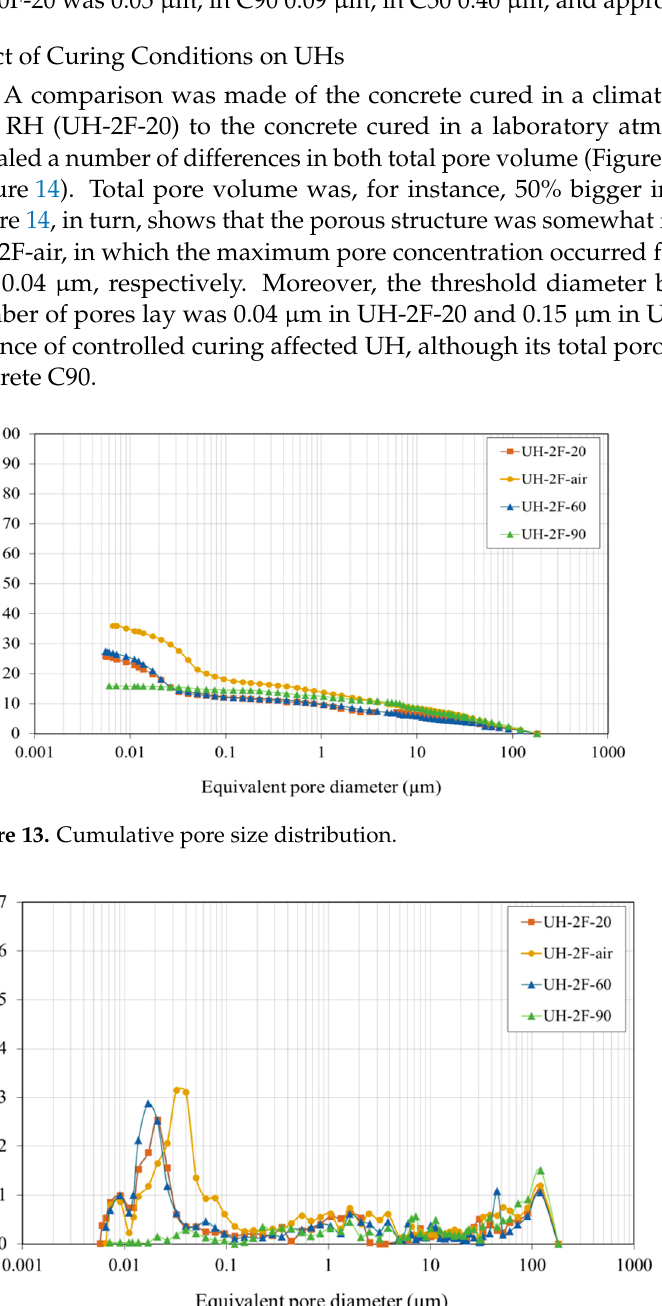
Table 3. MIP results. UH-0F-20